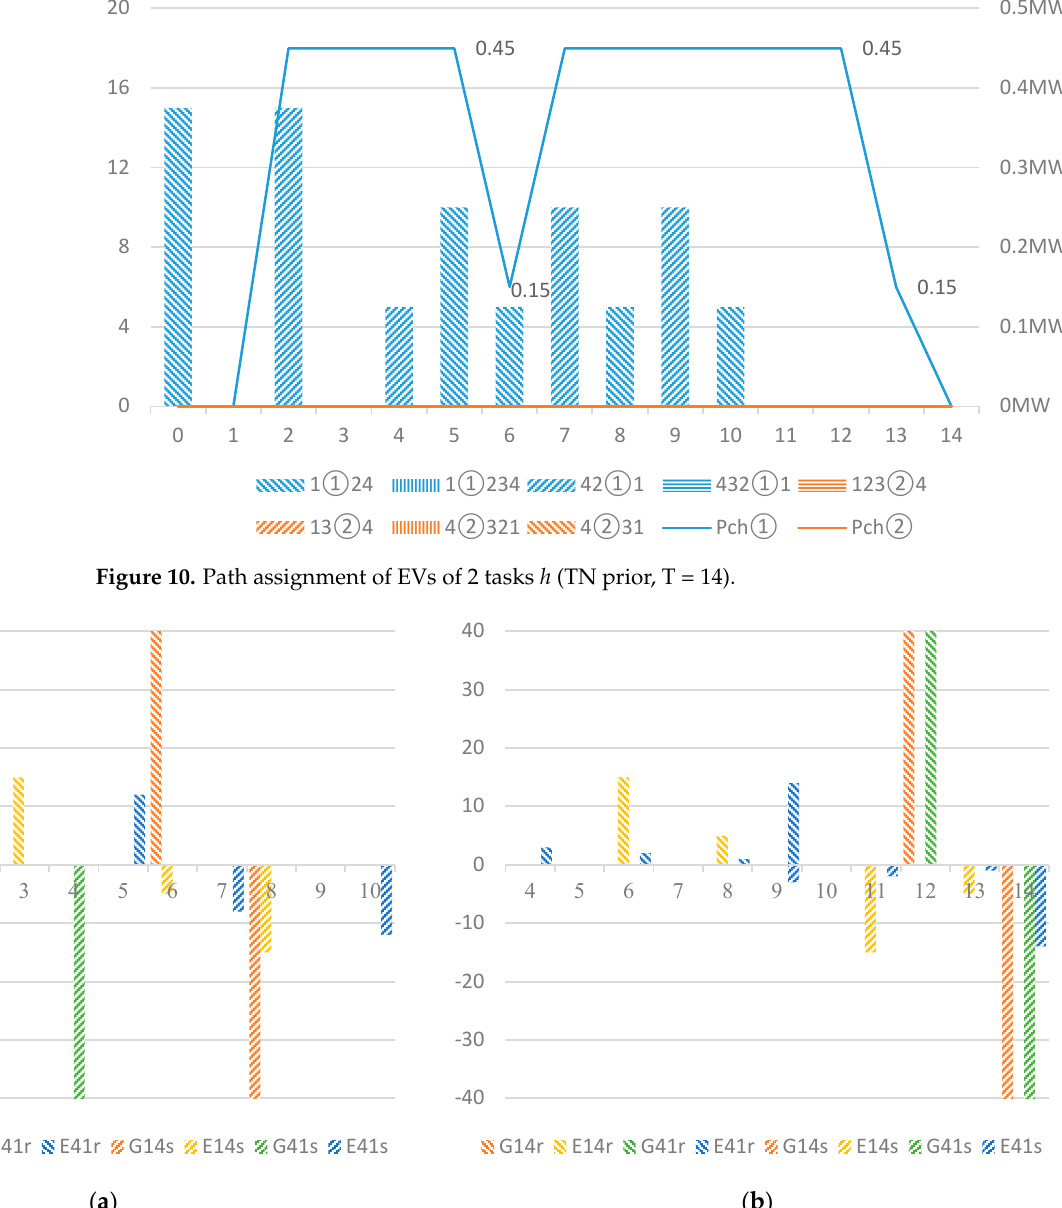
Figure 11. ( a ) Instantaneous flow of task 1 for time period 0 to 10 under PDN prior; ( b ) instantaneous flow of task 2 for time period 4 to 14 under PDN prior.